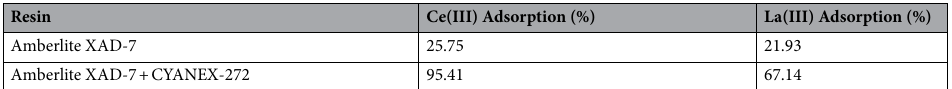
Table 4. Investigating the role of CYANEX-272 impregnation on the adsorption process (Adsorption conditions: [Ce -La] = 200 mg/L, pH = 5, resin dose = 0.4 g, agitation time: 24 h, Temperature: 25 °C).